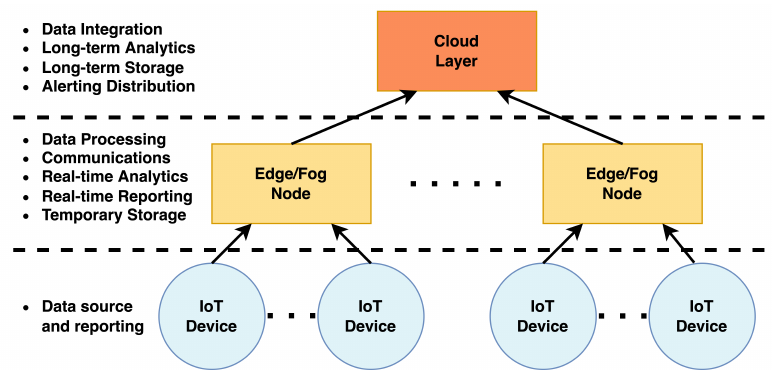
Figure 1. Three-layer architecture for edge-computing-based solutions. Adapted from